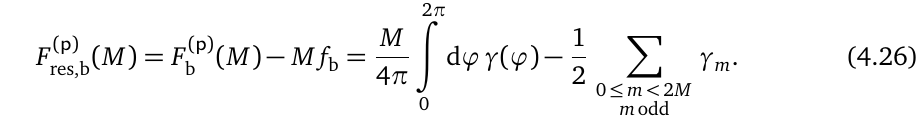
Figure 6: Complex structure of the alternating sum over the Γ ω -plane (integrand of (4.31a)), together with the contour C = C phase jump is present and the 2 π -periodicity along the imaginary axis is continuous, but nevertheless the upper and lower contour are equal due to the reversed phase in the upper and lower